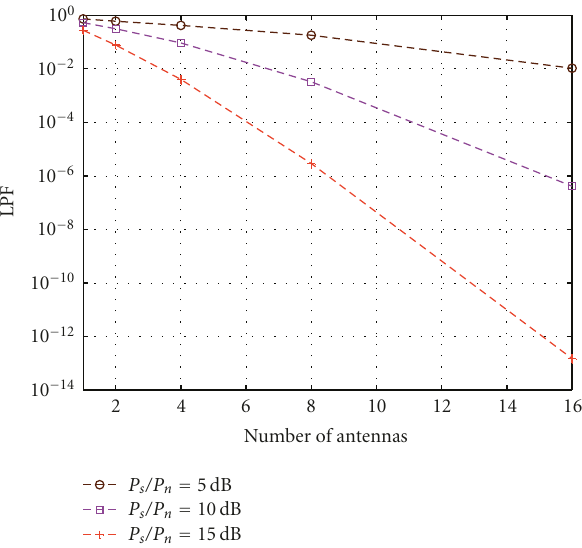
Figure 10: Loss probability due to fading using beamforming techniques ( L =